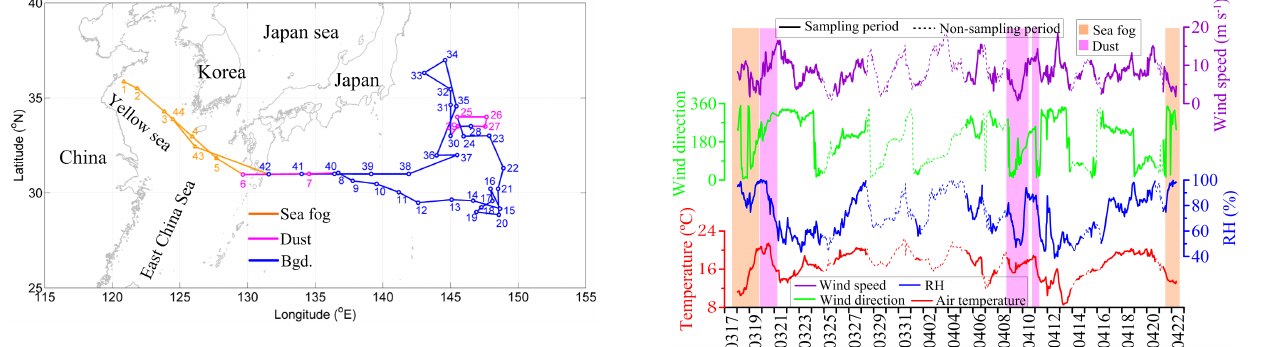
Figure 2. The meteorological parameters collected during the sam- pling period (solid line). Wind speed is in purple, wind direction in green, RH in blue and temperature in red. The orange shadings indi- cate the period of sea fog contact and pink indicate the dust period. Non-sampling period is shown with dashed